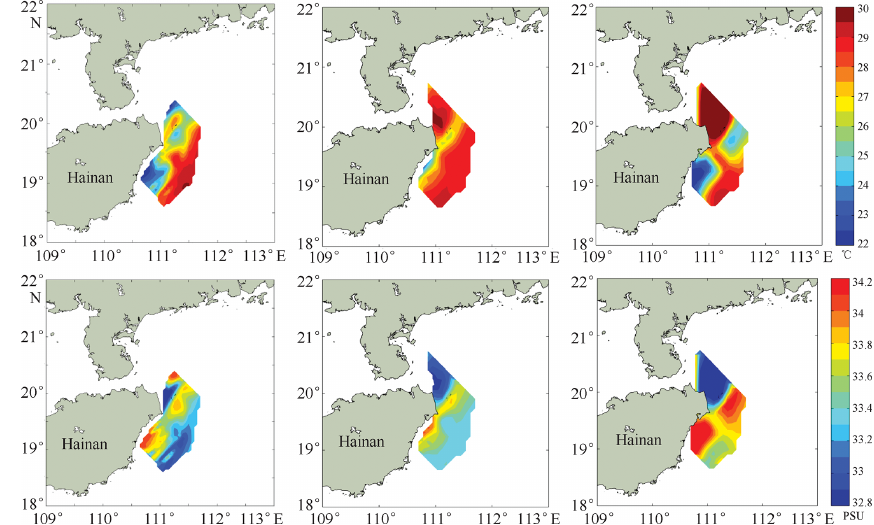
Figure 5. The horizontal distributions of temperature (upper panels) and salinity (lower panels) at 10m depth layer from the in situ observa- tions of Qiongdong cruise (left column), Mercator Océan (middle column), and SCSOFS (right column), respectively.